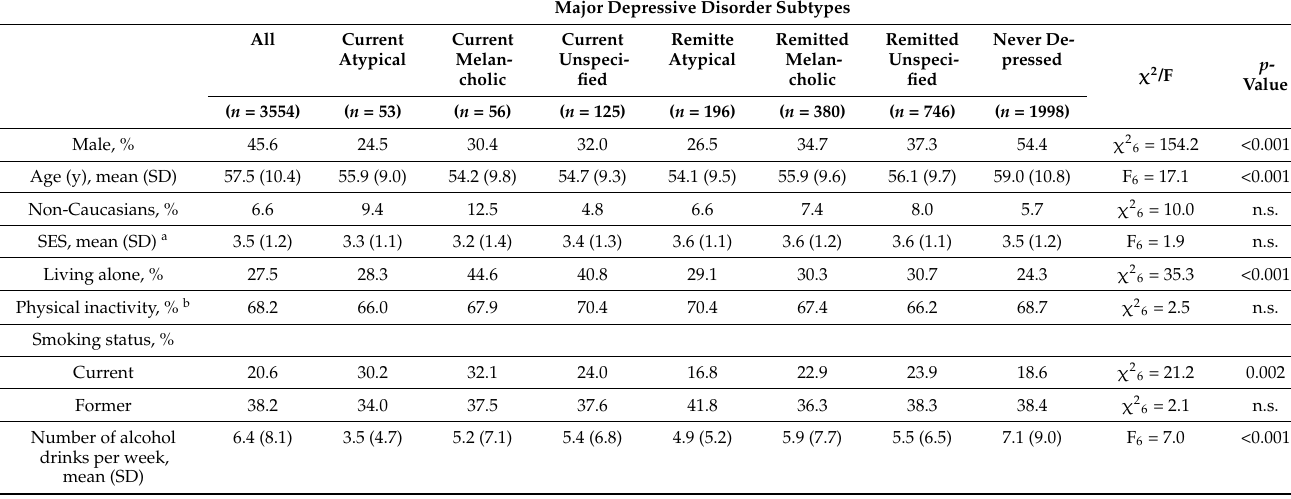
Table 2. Characteristics of the participants who responded to the food frequency questionnaire and the psychiatric interview ( n = 3554).